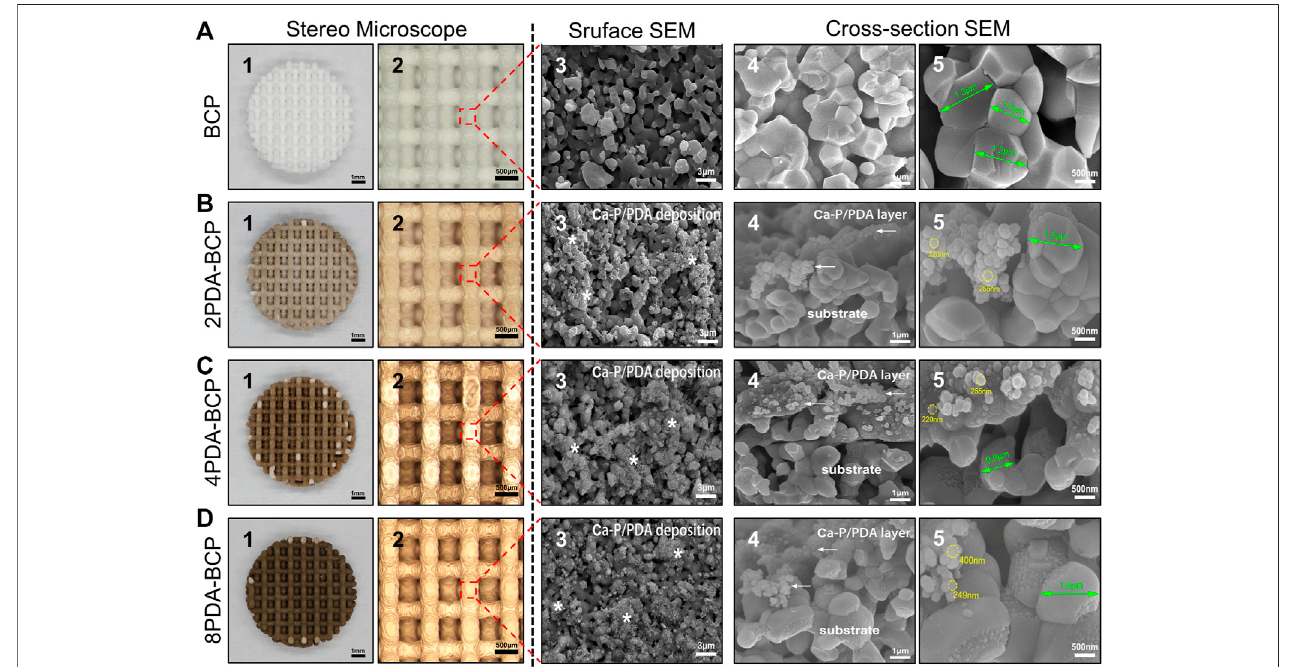
FIGURE2| Macroscopic morphology, surfacemicrostructures,andcross-sectionmorphologiesof3DprintedscaffoldsandPDAmodi fi cationscaffoldsonstereo microscopeandscanningelectron microscope. (A) BCP. (B) 2PDA-BCP. (C) 4PDA-BCP. (D) 8PDA-BCP.Thewhitestarsindicatedepositioncomposed ofCa-P/PDA, the white arrows indicate the PDA layer and amorphous Ca-P nanoparticles. The grain size of BCP (green arrows), the size of new formation amorphous Ca-P nanoparticles (yellow circle). Scale bars = 1 mm, 500 μ m, 3 μ m, 1 μ m, 500